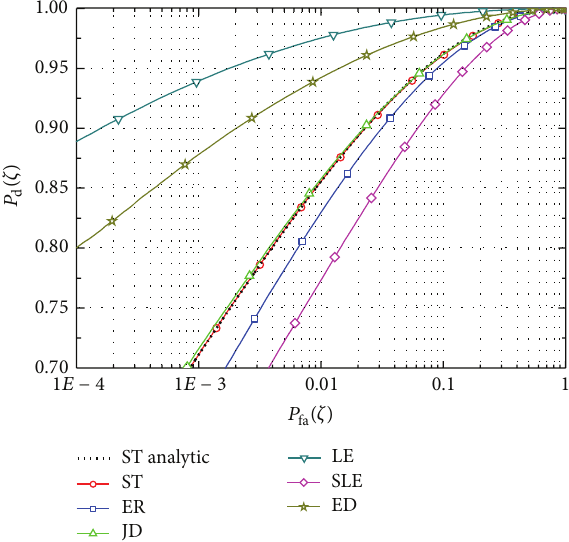
Figure 16: ROCs over a Rayleigh fading channel, for 𝐾 = 4, 𝑁 = 100, 𝑃 = 6, and SNR 1 = SNR 2 = SNR 3 = SNR 4 = SNR 5 = SNR 6 ≈ − 3 . 6986 dB, with 𝜇 = 0 . 5 dB for the LE and the ED.